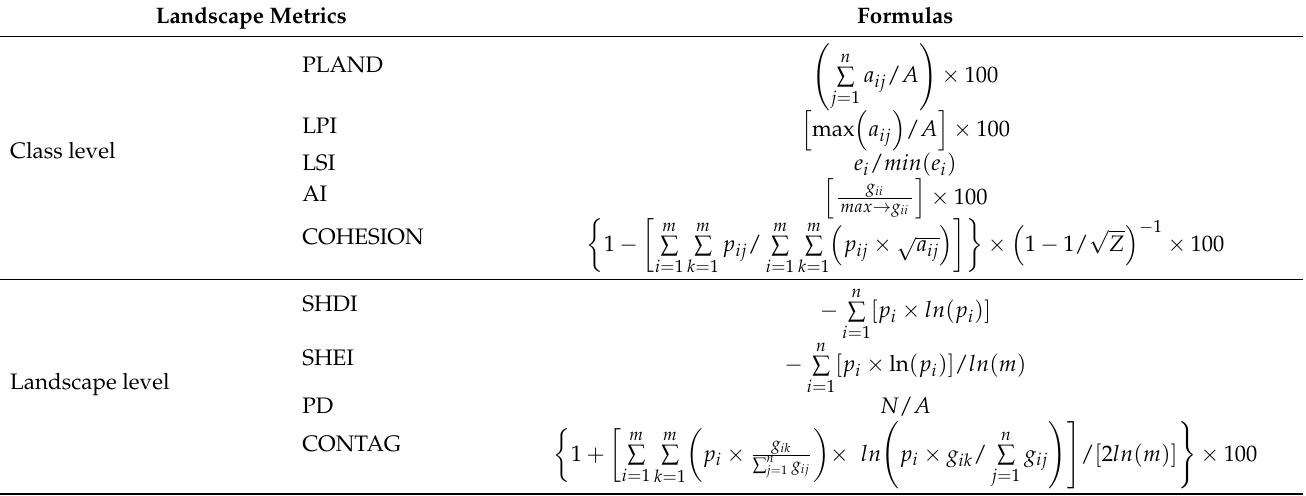
Table 2. The landscape metrics selected in this